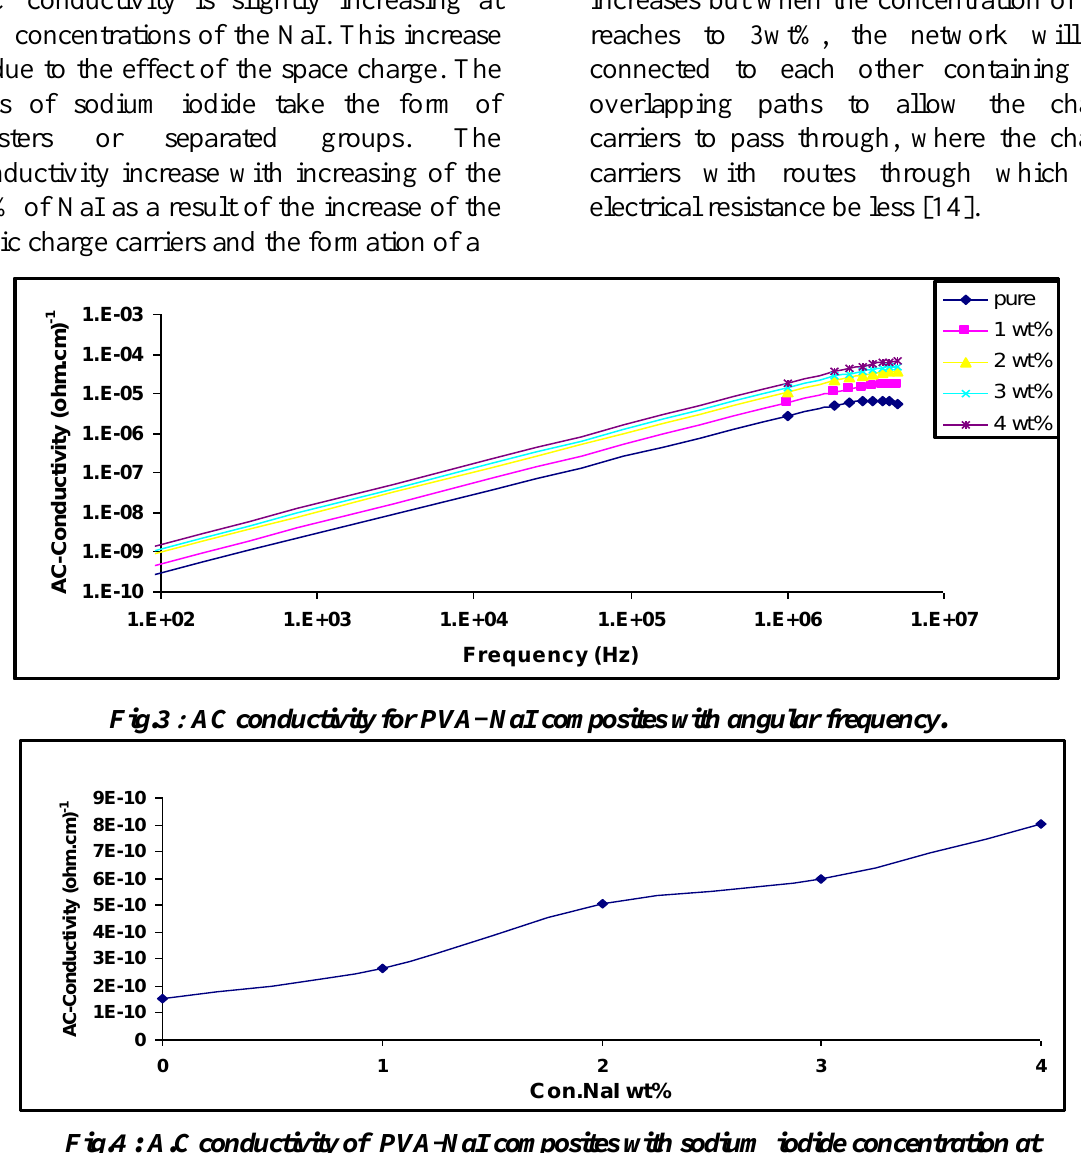
Fig.4 : A.C conductivity of PVA-NaI composites with sodium iodide concentration at 50Hz and 298K